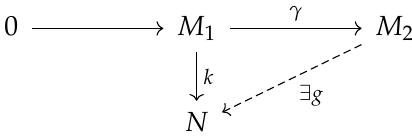
Figure 4. The diagram for a normal injective R -hypermodule